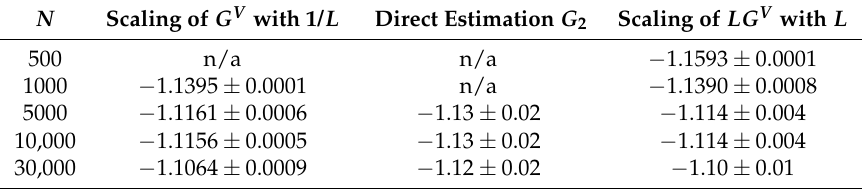
Table 4. KB integrals in the thermodynamic limit G ∞ for a LJ system at T = 2 and ρ = 0.4 (dimensionless units). Values of G ∞ are computed from systems with various number of particles N and using the different methods listed in Table